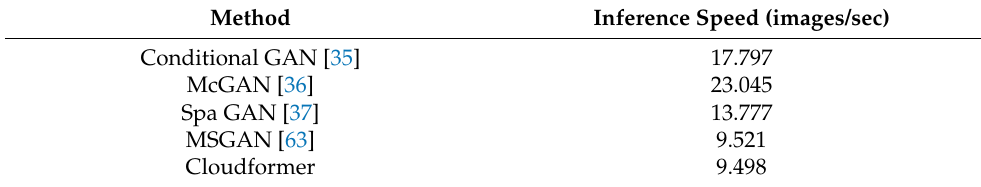
Table 5. Average inference speed on RICE1 test set.